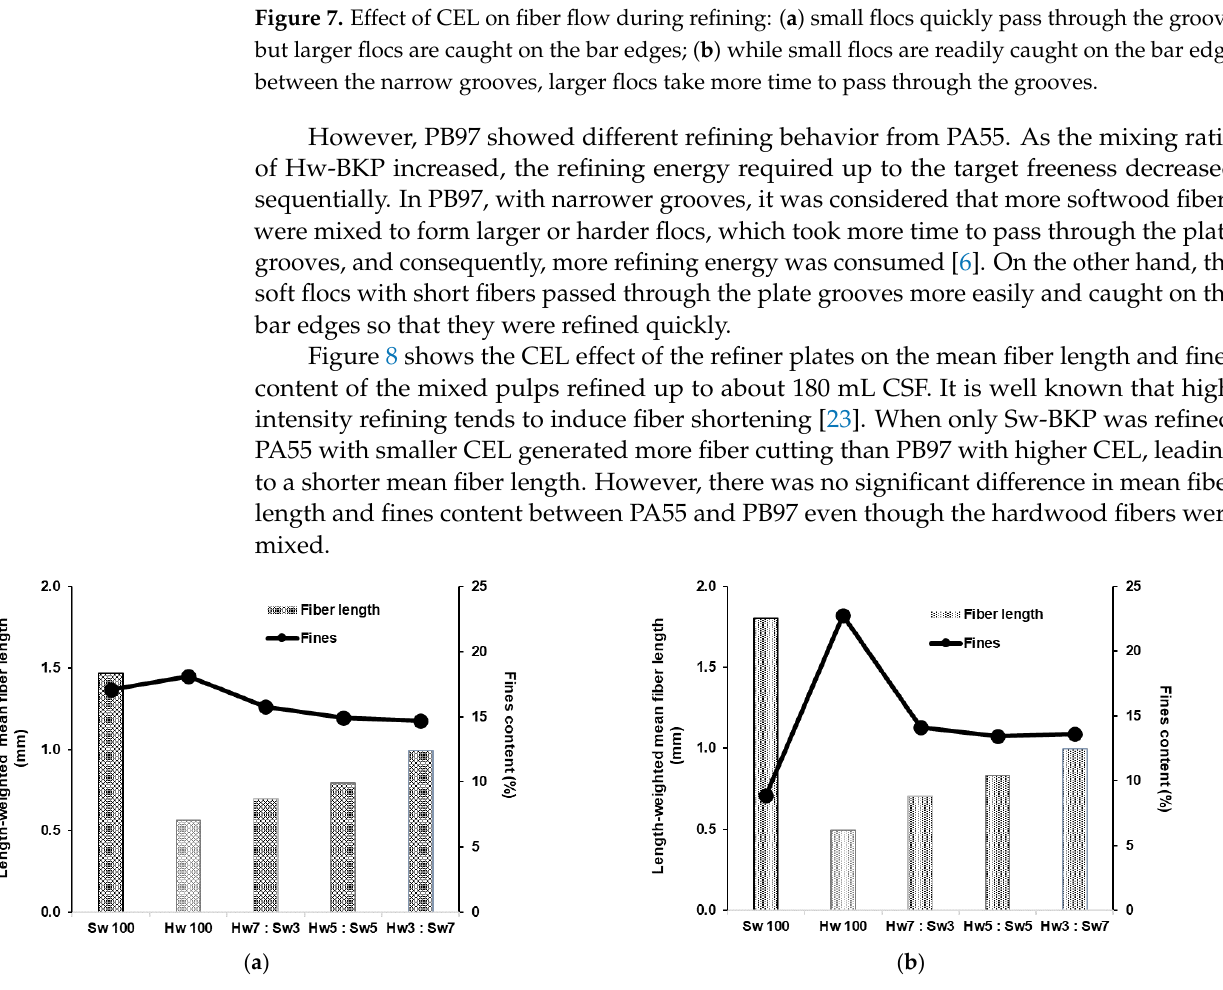
( b ) Figure 9. Effect of CEL on WRV of the mixed pulps: ( a ) PA55; ( b ) PB97. In conclusion, irrespective of the plate CEL, when refining using a plate with sharp bar edges, fiber properties of the mixed pulps could be developed faster while reducing refining energy consumption than refining Sw-BKP and Hw-BKP separately. In addition,